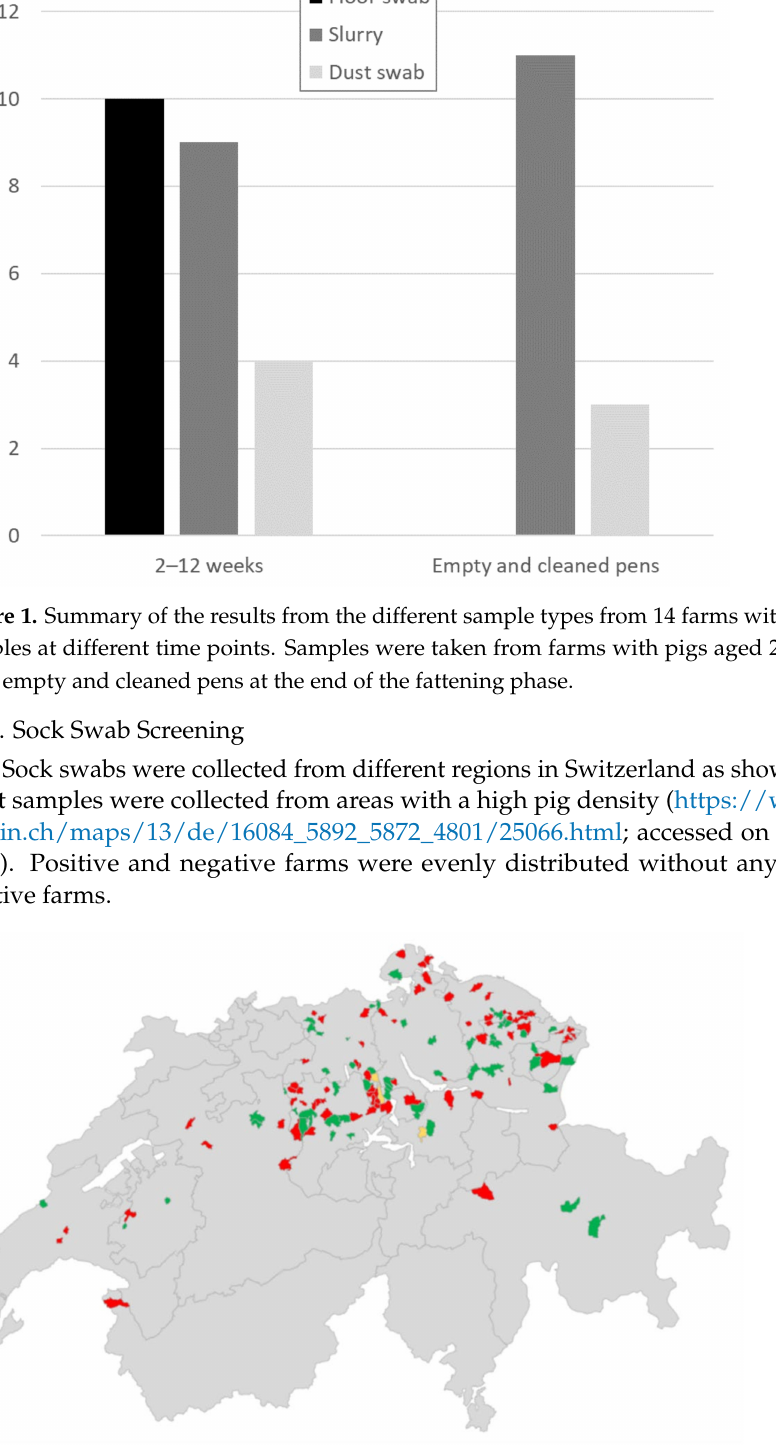
Figure 2. Distribution of the farms from the sock swab screening. The postcodes (from a municipality) in which sampled farms were located are marked with colour. Red colour marks postcodes with one or more HEV-positive farms; green marks postcodes with one or more HEV negative farms and yellow marks postcodes, in which positive and negative farms were found. The map was created with